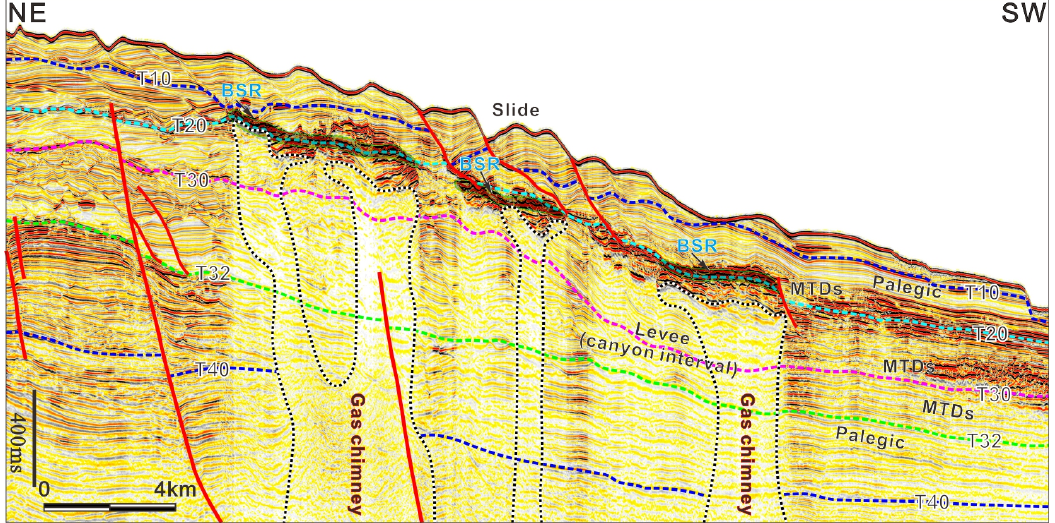
Figure 10. Characteristics and distribution of BSRs in the profile on the canyon ridge.